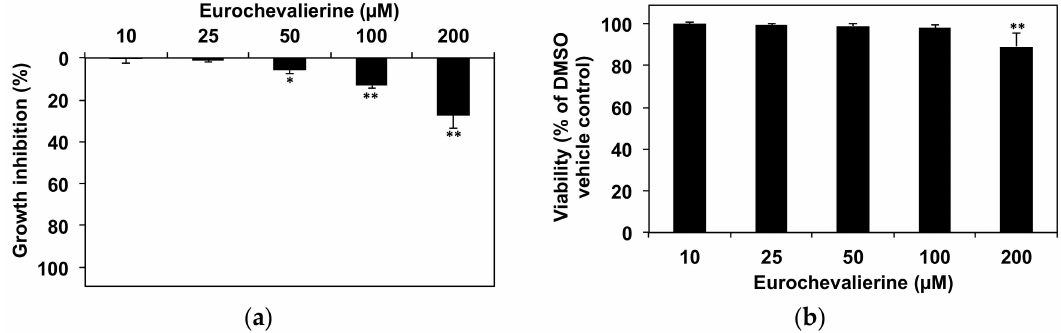
Figure 7. Only very high concentrations of eurochevalierine impair the growth of healthy primary human CD34 + stem/progenitor cells. CD34 + cells were incubated with the indicated concentrations of eurochevalierine and cell growth ( a ) and viability ( b ) were assessed after 72 h of treatment. Results correspond to the mean ± SD of three independent experiments with * and ** indicate p < 0.05 and p < 0.01 versus control.